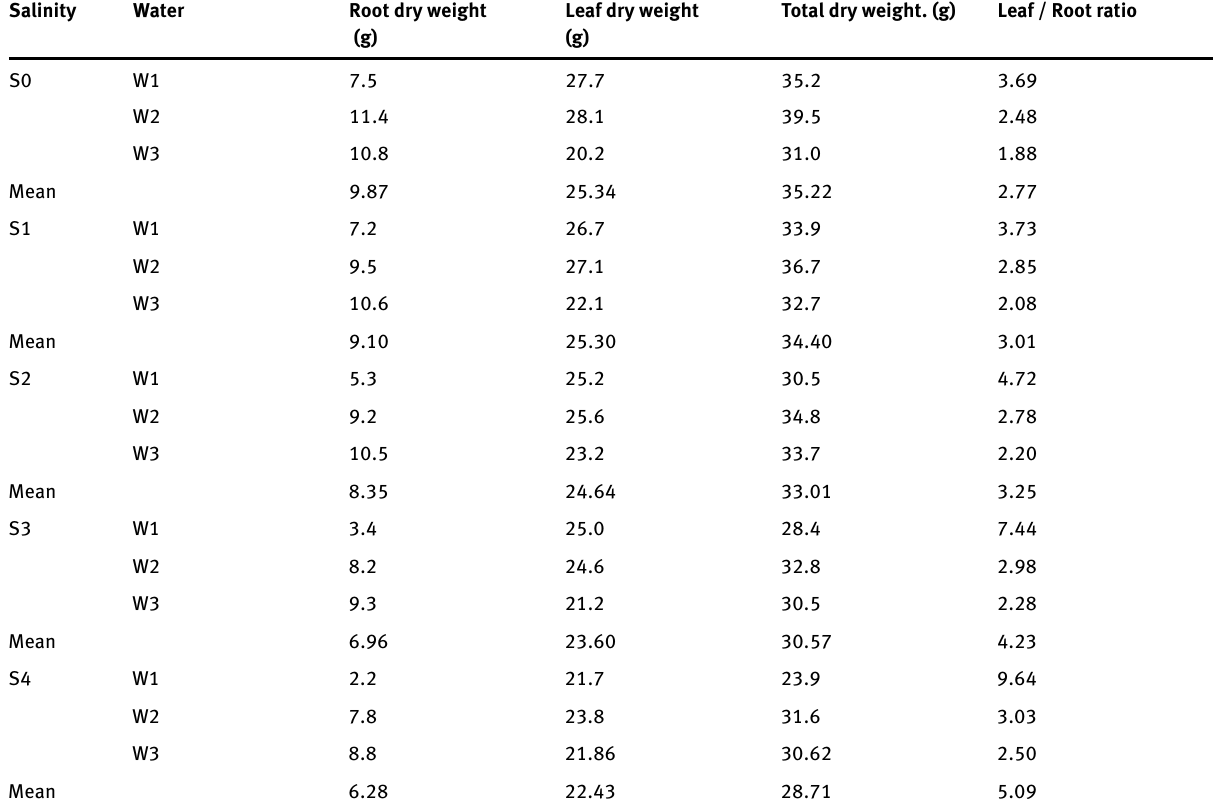
Table 3: Mean values of the tested parameters Salinity